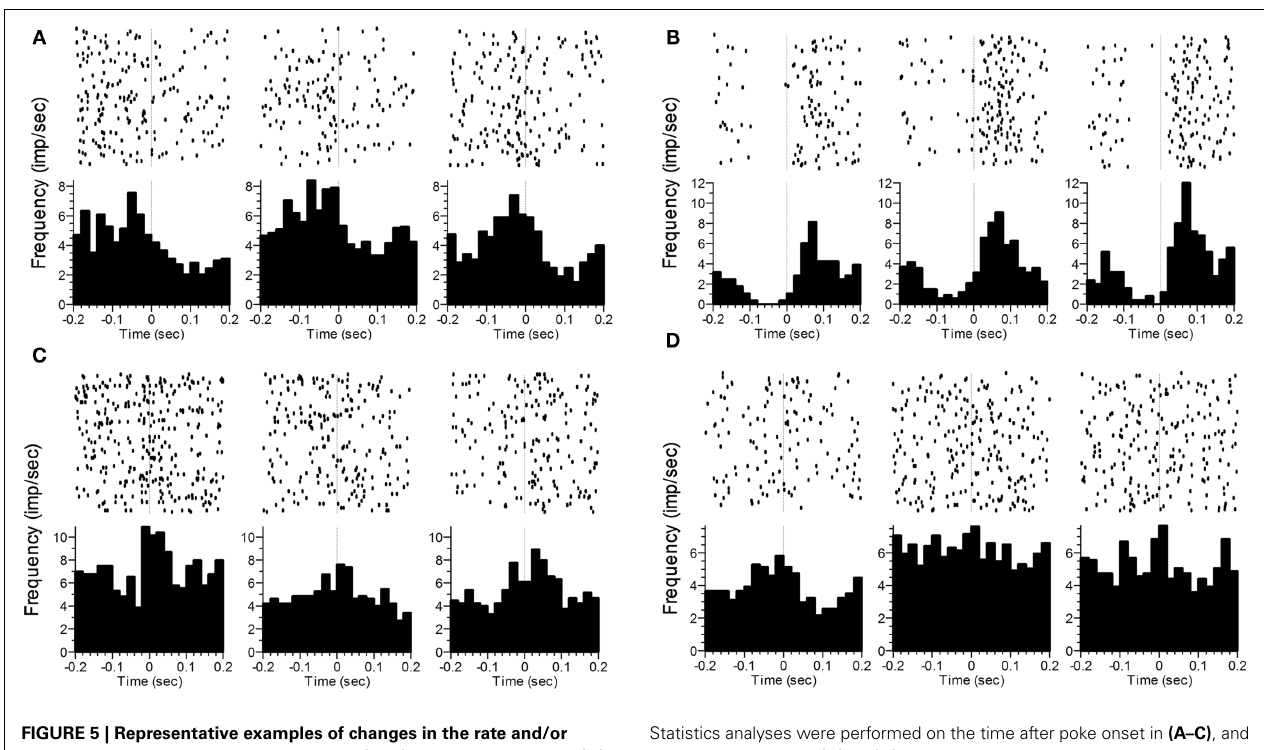
FIGURE 5 | Representative examples of changes in the rate and/or pattern of firing related to poke initiation (A–C) or poke termination (D). The time of photobeam switch breakage (initiation) or completion (termination) is indicated by the vertical dashed line at t = 0.The three columns represent the three phases (VI1 poking, FI poking,VI2